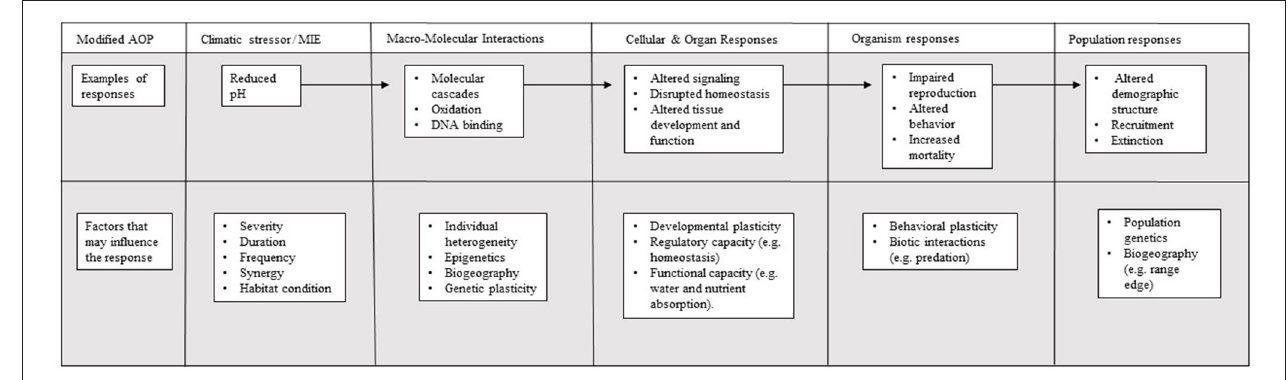
FIGURE 1 | Conceptual diagram of the Adverse Outcome Pathway (AOP) linking the effect of the toxicant, considered to be ocean acidification, with the mechanistic toxicity pathway, and adverse outcomes (based on Ankley et al.,